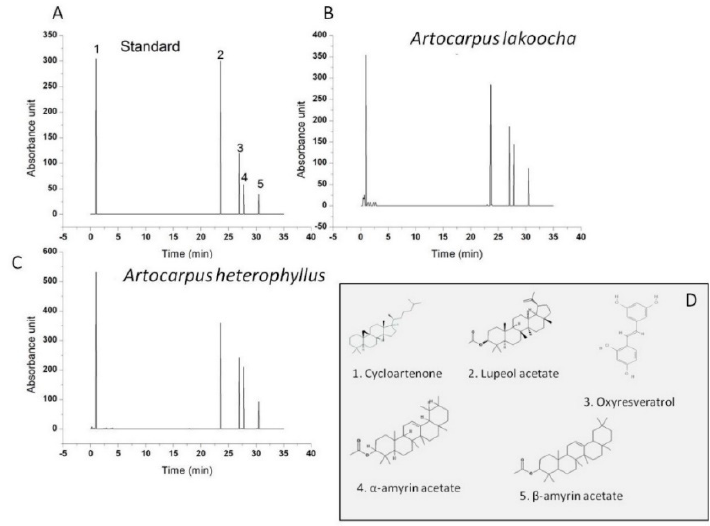
Figure 2. ( A ) HPLC chromatogram of standards identified in Artocarpus lakoocha Roxb. and Artocarpus heterophyllus Lam.: cycloartenone ( 1 ), lupeol acetate ( 2 ), oxyresveratrol ( 3 ), α‐ amyrin acetate ( 4 ), and β‐ amyrin acetate. ( B ) HPLC chromatogram of Artocarpus lakoocha flower extracts. ( C ) HPLC chromatogram of Artocarpus heterophyllus Lam. flower extracts. ( D ) The chemical structure of the main components.